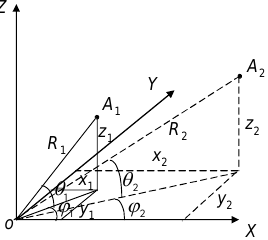
Fig.2 The determination of neighboring